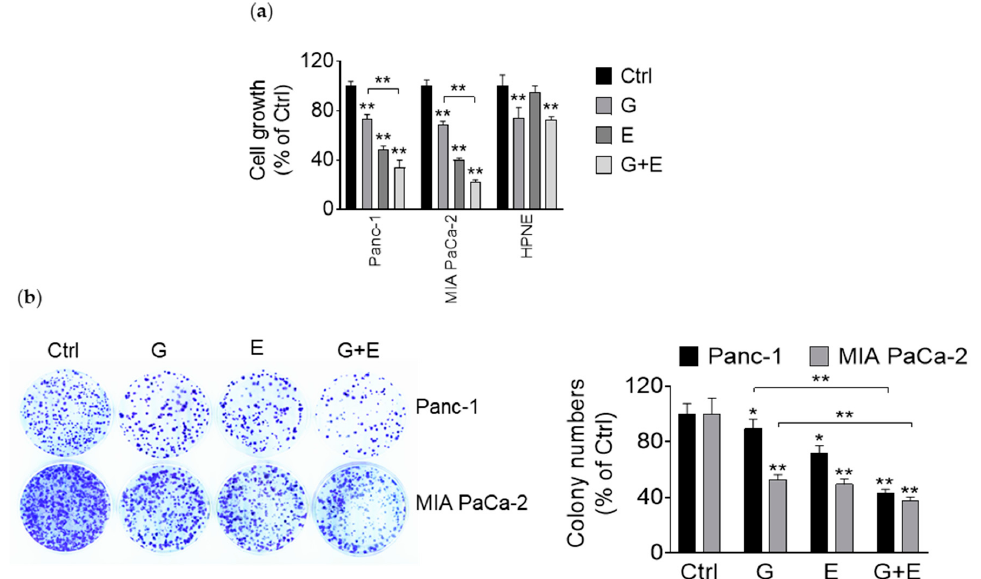
Figure 5. EGCG enhances the cell growth inhibitory effect of gemcitabine in pancreatic cancer cells. ( a ) Cell growth was determined in Panc-1, MIA PaCa-2, and HPNE cells following treatment with EGCG (40 µM), gemcitabine (20 nM), or both for 72 h. Results are expressed as a percentage of control. ** p < 0.01 vs. control. ( b ) Panc-1 and MIA PaCa-2 cells were treated with EGCG (E), gemcitabine (G),